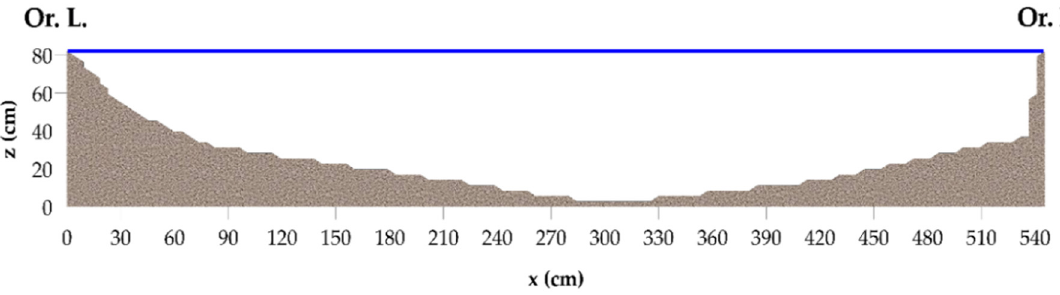
Figure 5. Scheme of the ADV measuring points (1 – 15), uniformly distributed along five hydrometric lines (A – E). The ADV moved along a woody binary installed on a steel footbridge, and then blocked at each measuring point during the acquisitions. The two parameters h (m) and B (m) are respectively the water level and width at bankfull of the ADV cross section, which vary according to the flow rate. The continuous dark blue line indicates the water level at bankfull. (from Errico et al. [1], modified).